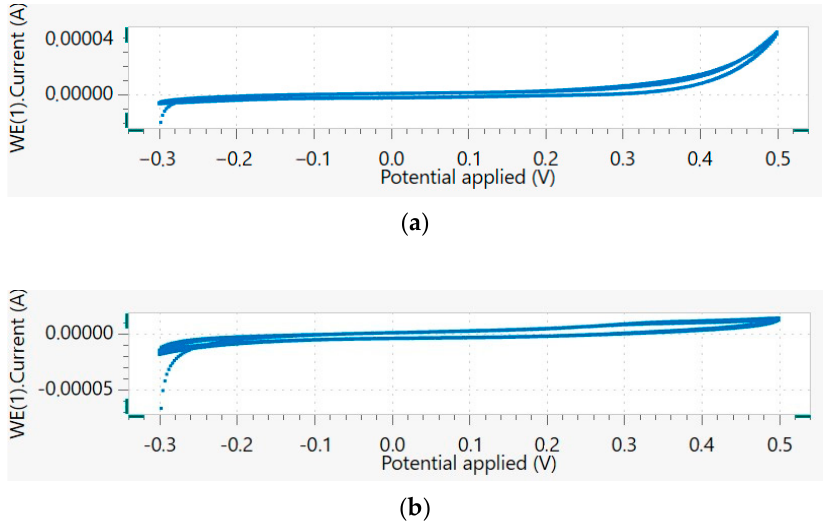
Figure 12. CV voltammograms of CV vs. Ag.AgCl for ( a ) M6 and ( b ) M8 at the end of closed-circuit operation.